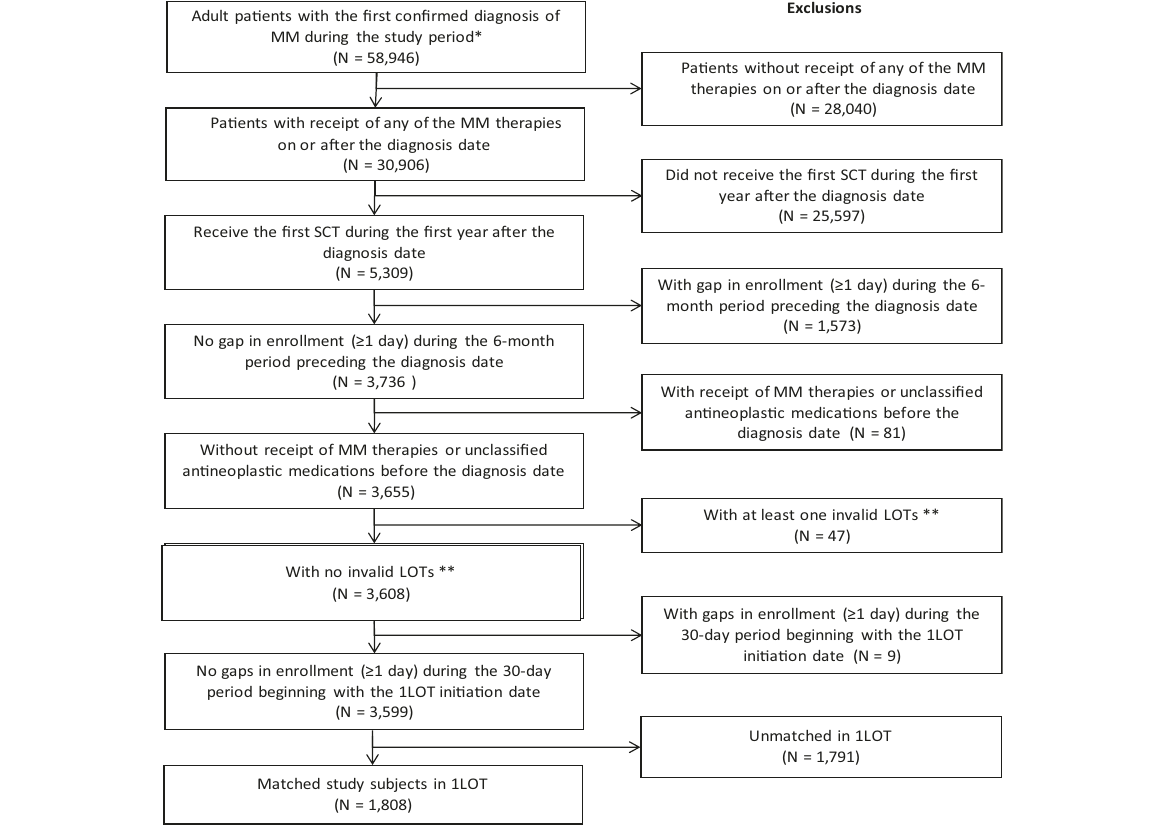
Fig. 2 Patient selection. Footnote: LOT = Line of therapy. MM = Multiple myeloma. SCT = Stem cell transplant. *Con fi rmed diagnosis is de fi ned as at least one inpatient claim, or at least two non-diagnostic outpatient claims within 30 to 365 days apart with a diagnosis of MM (ICD-9-CM code 203.0x or ICD-10-CM code C90.0). **Missing information on supply amounts of MM therapy that could not be imputed, or at least one day with evidence of receipt of multiple proteasome inhibitors